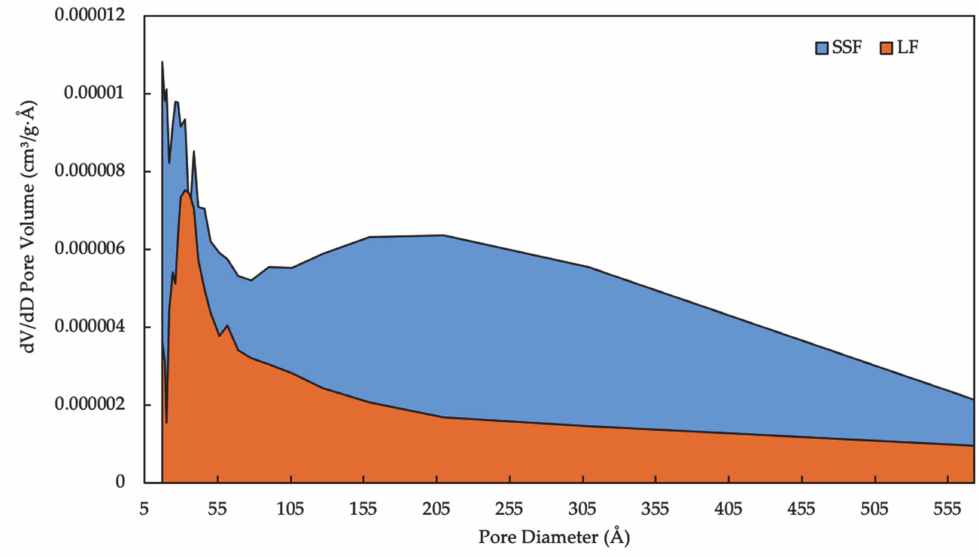
Figure 4. Pores distribution of SSF and LF.